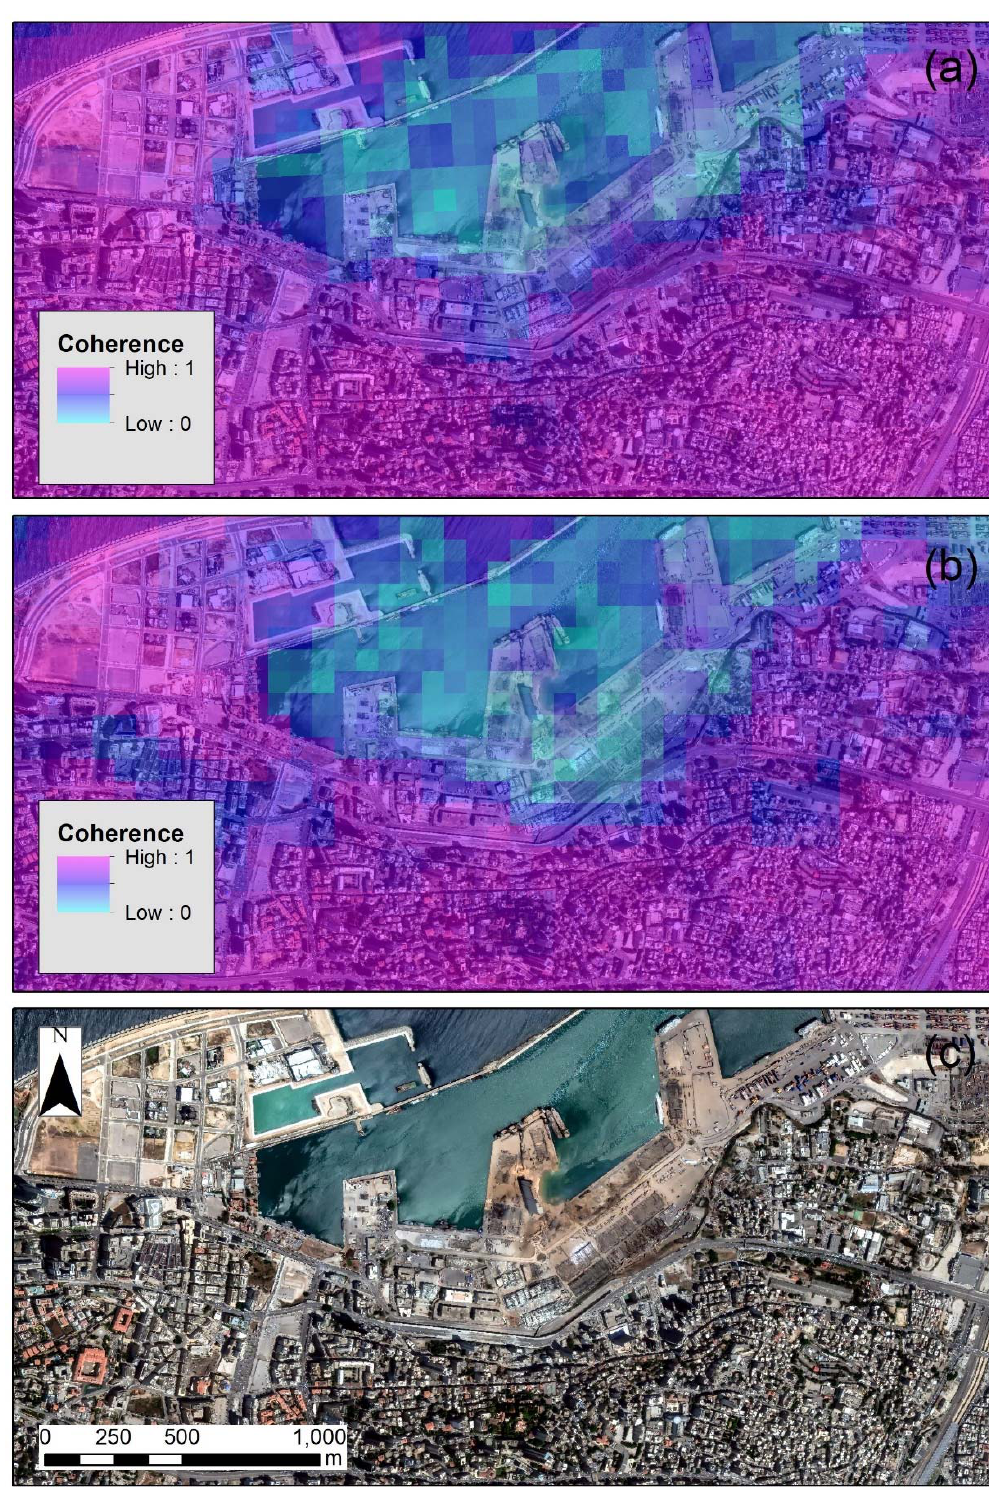
Figure 8. ( a ) Coherence map generated from the descending orbit images (see Table 2). ( b ) Coherence ( a ) Coherence map generated from the descending orbit images (see Table 2). map generated from the ascending orbit images (see Table 3). ( c ) High ‐ resolution WorldView ‐ 2 ( b ) Coherence map generated from the ascending orbit images (see Table 3). ( c ) High-resolution image. WorldView-2